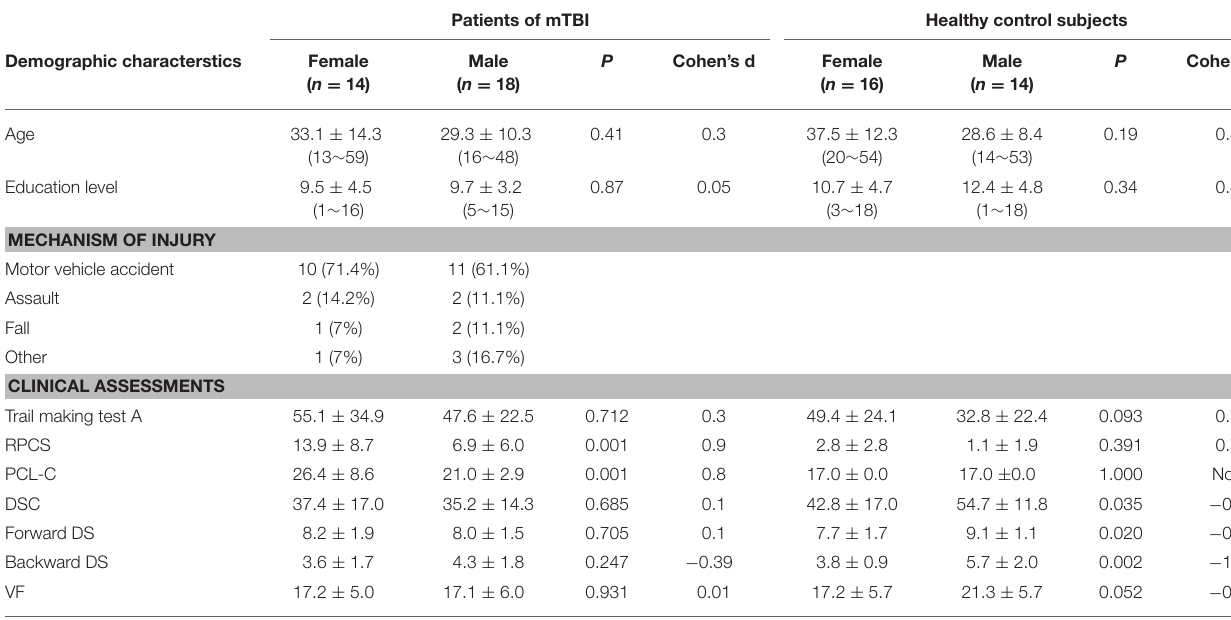
TABLE 1 | Demographic and Clinical assessments in patients of mTBI and healthy controls. Patients of mTBI Healthy control subjects